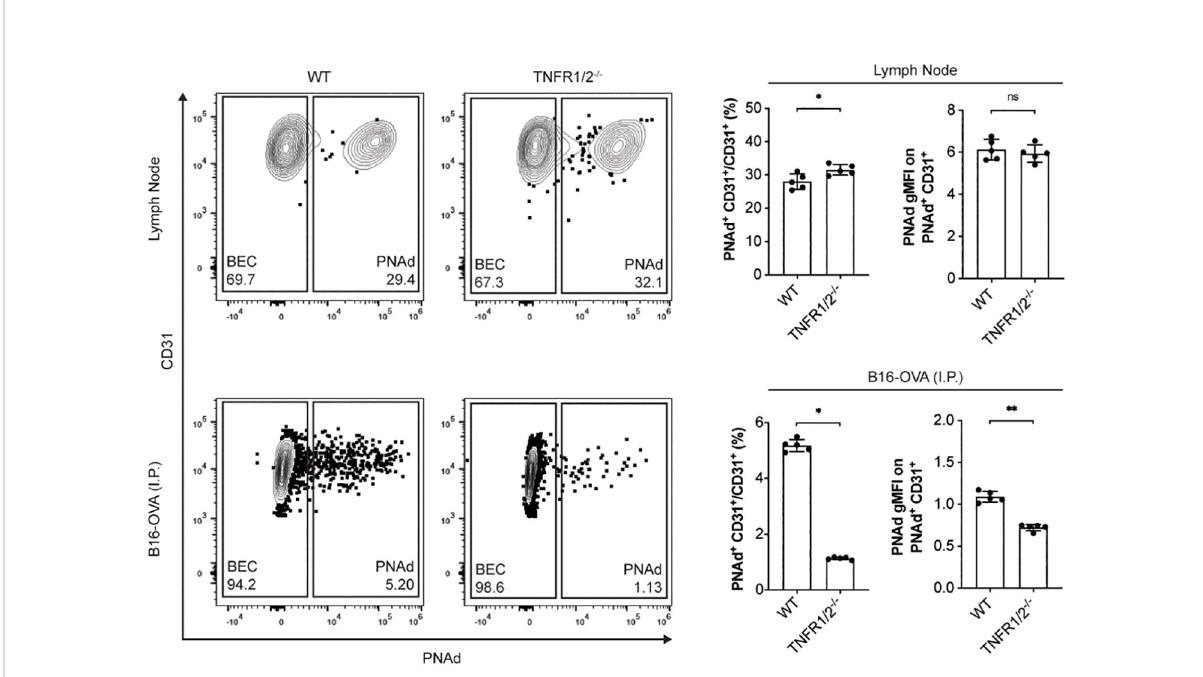
FIGURE 5 Tumor necrosis factor receptor signaling controls PNAd expression in most TEC but not in LN BEC. C57BL/6 WT or TNFR1/2 -/- mice were I.P. injected with B16-OVA cells and tumors were harvested 14 days later. LN were harvested from non-tumor-bearing mice. Resected tissues were prepared for fl ow cytometry as described in Methods. Representative fl ow cytometry plot, percentages, and gMFI of PNAd on CD45 neg Ter119 neg PDPN neg CD31 + endothelial cells in CD45 + depleted LN and I.P. tumors suspensions. PNAd gMFIs were calculated on cells gated above FMO control. Data represents one experiment, n = 5 LN or tumors per group. Results are mean ± SD analyzed by unpaired Welch ’ s t-test. ns: p>0.05, *p<0.05,